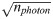
Low-Photon Regime.(A) Control dyes having known long (Coumarin 153) and short (Erythrosin B) lifetimes were mixed at a fixed ratio. From the measured master curve of photon arrival times, a variable number of photons are randomly sampled, generating histograms with a variable number of photons. (B) Bias in the estimated short-life photon fraction, fS, decreases with increasing photon number. Data points represent the average of the posterior mean (squares) or mode (circles) for 300 independent samplings for each photon count. Error bars are s.e.m. (C) Black circles: measured sample standard deviations from data in Fig 2B averaged across the 300 independent samplings. The sample standard deviation decreases approximately as nphoton. Power law fit to a × xb for all but the four lowest values of nphoton shown in gray, with a = 0.04 ± 0.01 and b = −0.48 ± 0.04 (95% confidence interval).